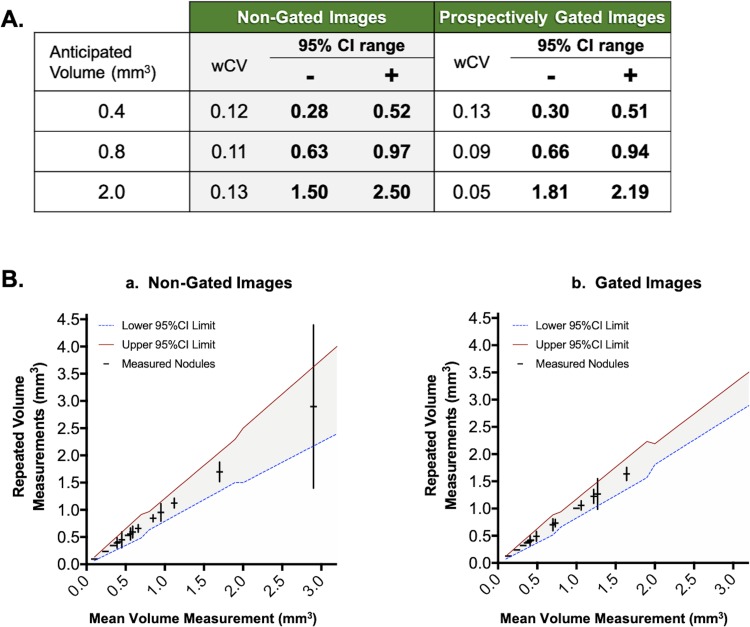
QIBA-inspired profile for predicting tumor volumetry precision across variable tumor sizes in gated and non-gated images.Shown is a table of sample anticipated tumor volumes for which the wCV and upper/lower 95% CIs was determined in both non-gated and gated acquisitions (A). Triplicate tumor measurements (plotted as mean ± standard deviation) from an independent cohort of mice were plotted against the calculated 95% CIs (red and blue bounding lines) (B), demonstrating the validity of the size-dependent confidence prediction for both non-gated (a) and gated (b) images.